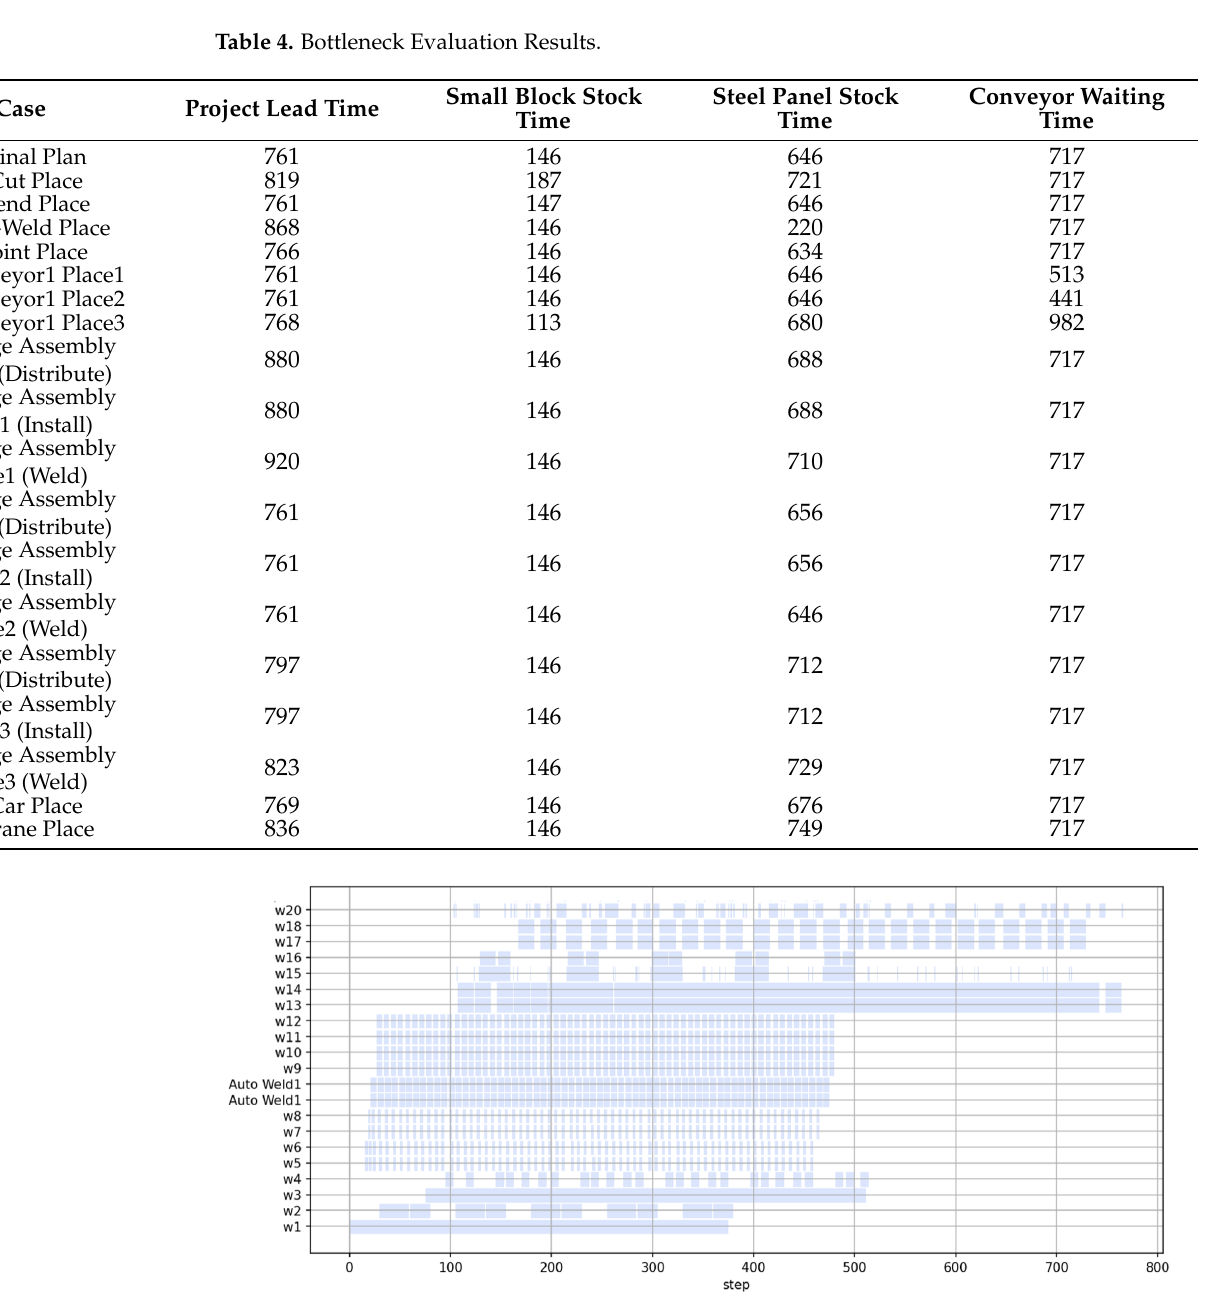
Figure 13. Gantt Chart of Workers in the Re-allocation Plan. Table 5. Comparison Result between Original Plan and Re-allocation